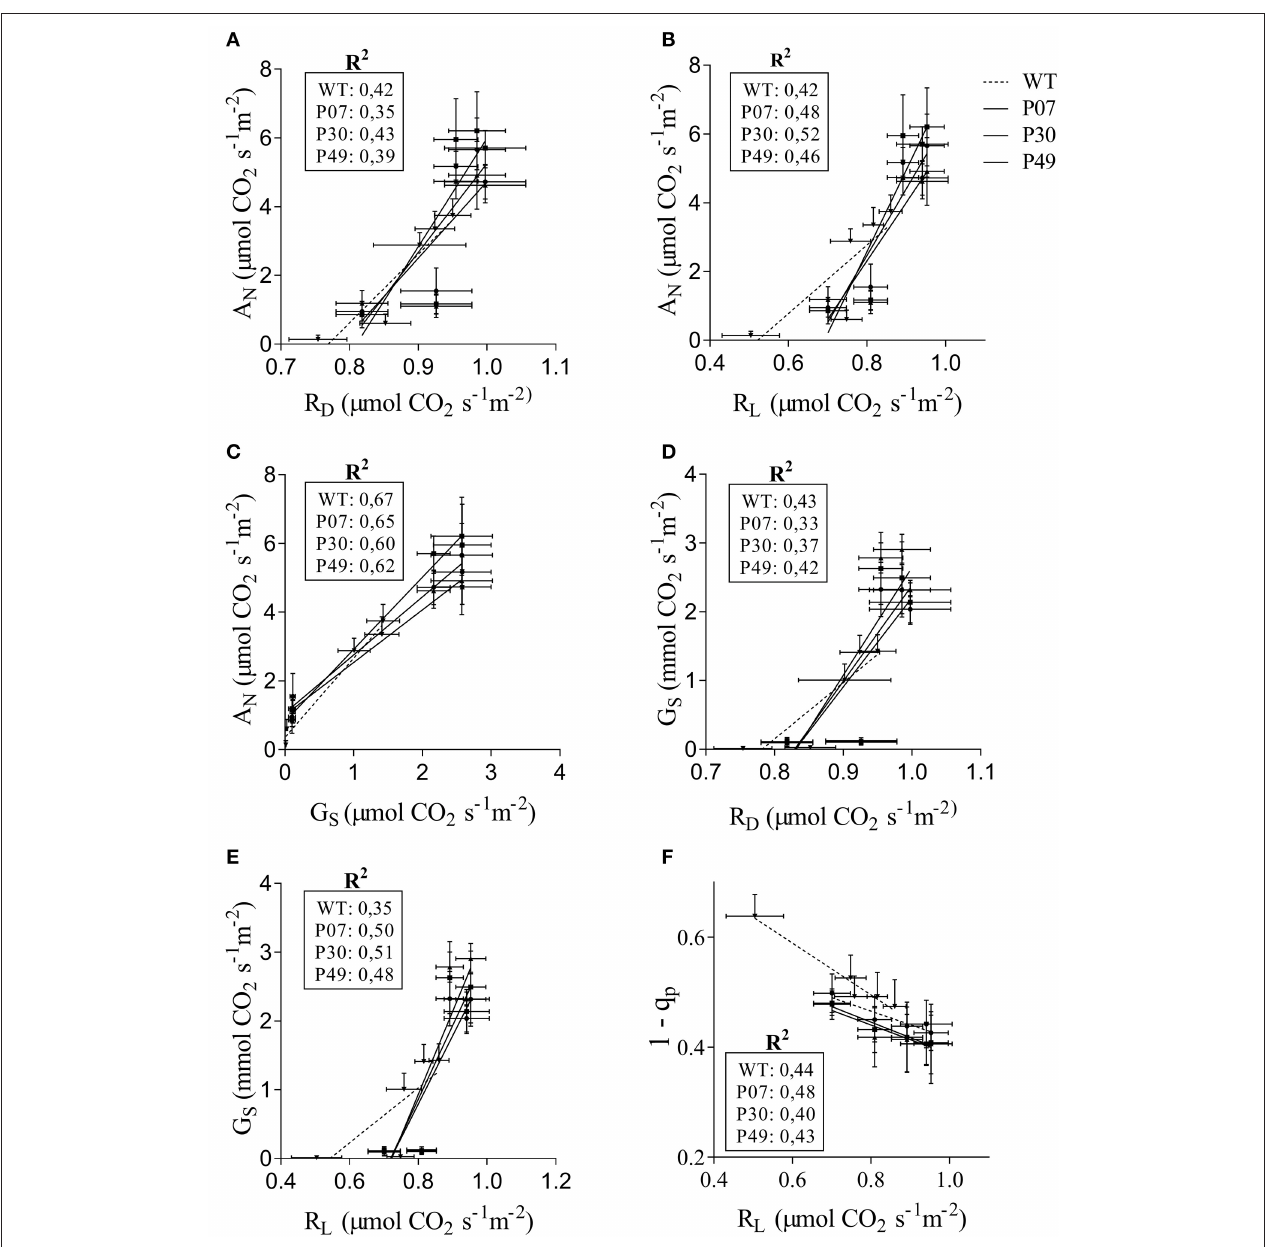
FIGURE 3 | Correlation of physiological parameters in WT and transgenic lines. The relationships of (A) R D , (B) R L, and (C) G S with A N was determined for WT (dashed line) and transgenic lines (plain lines). (D,E) G S as a function of R D and R L , respectively. (F) 1-qP as a function of R L . The curves were calculated for each line individually. Control, drought and recovery data were pooled together for the linear regression